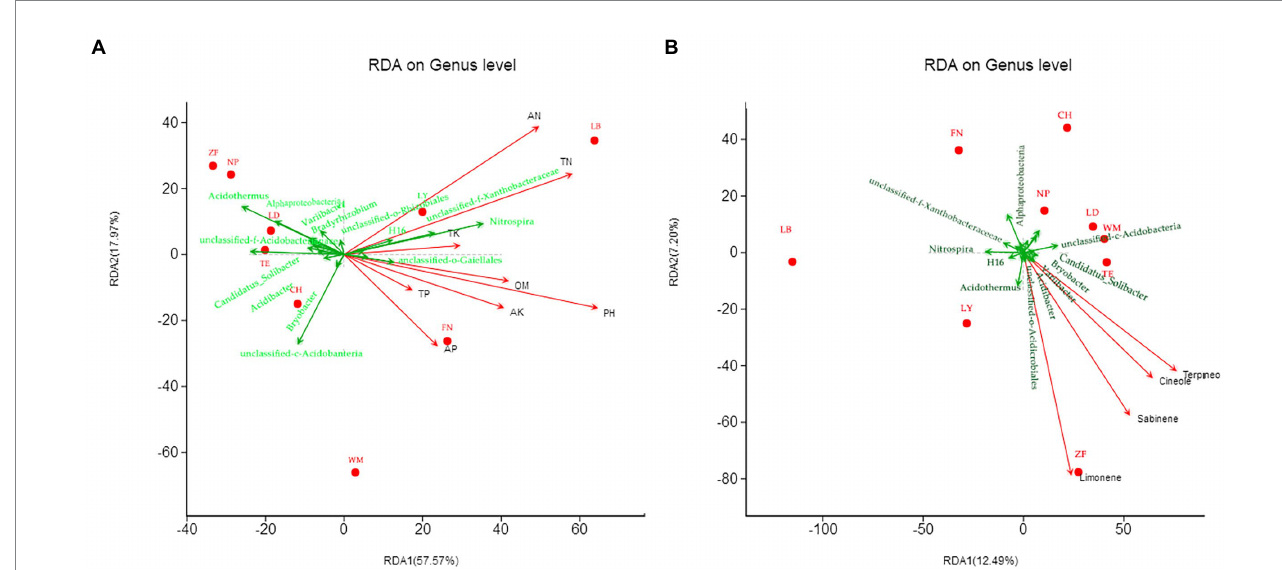
FIGURE 7 Canonical correspondence analysis (RDA) of rhizobacterial communities with soil chemical factors (A) and C. migao fruit bioactive compounds (B) across nine sites. The red dots represent different sample sites, the green arrows represent the top 20 abundance genera, and the red arrows represent soil chemistry and active ingredients, arrow length represents the degree of